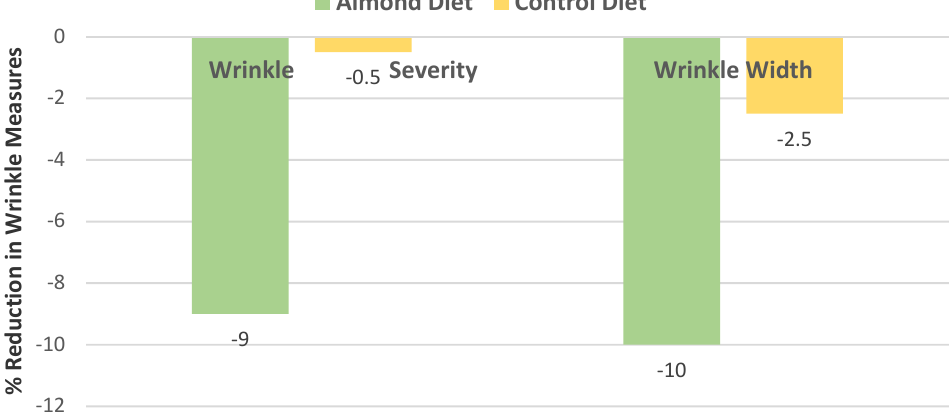
Figure 25. Almond group compared to carbohydrate-rich group on wrinkle measures ( p < 0.02 for both almond wrinkle measures) from baseline to 16 weeks [82].